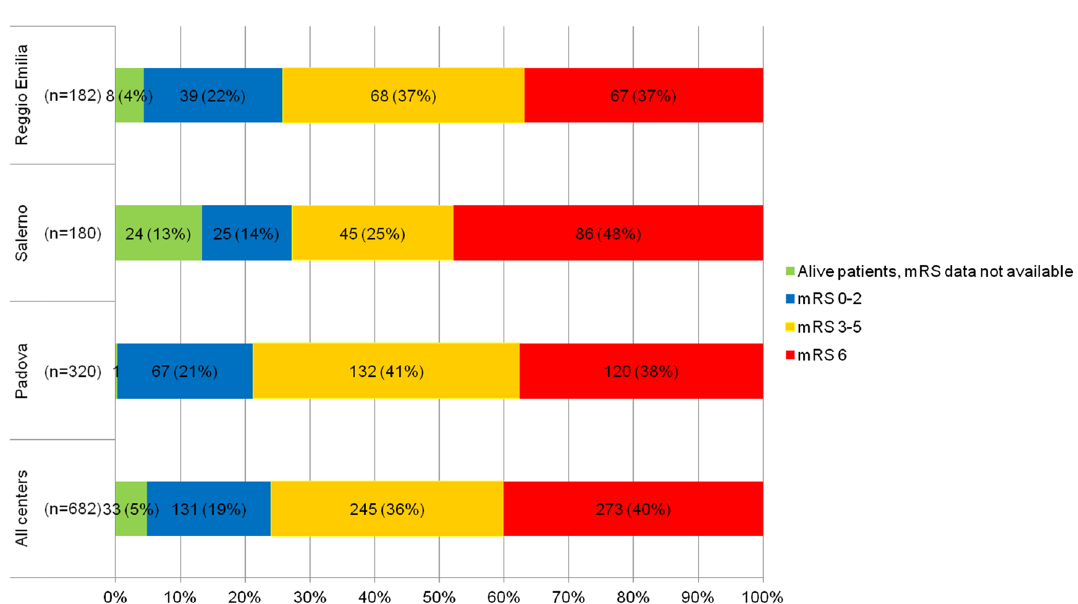
Fig. 1 Mortality and disability at 90 days from the index